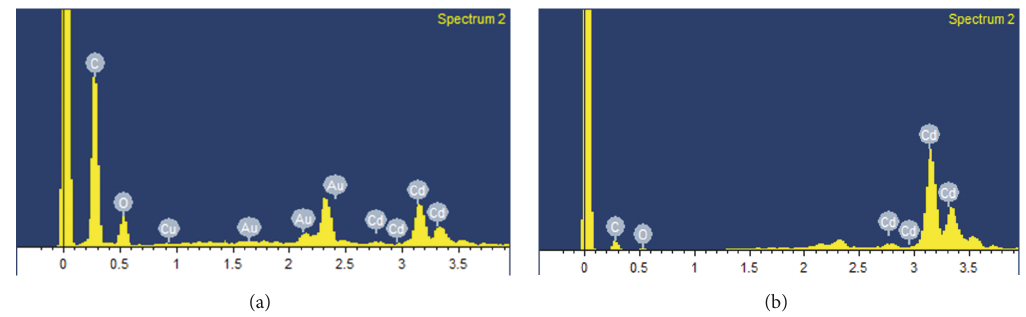
Figure 8: EDX spectra of (a) H 8 L and (b) Cd 2+ -H 8 L. EDX spectra for the region marked by an arrow in (b), and (c) of Cd 2+ -H 8 L in Figure 7.